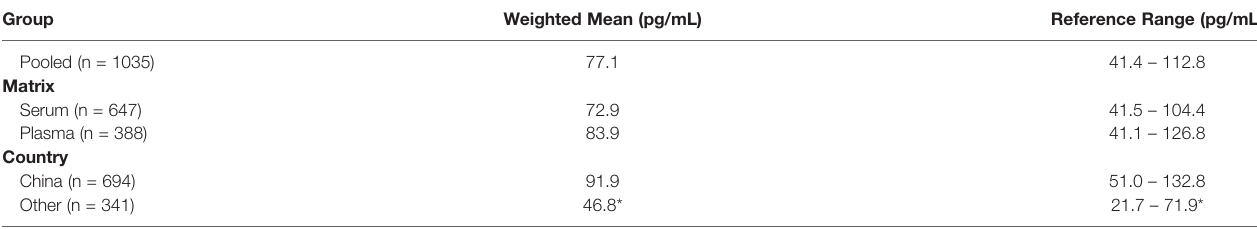
TABLE 2 | Circulating IL-37 weighted means and reference ranges for subgroups analyzed.